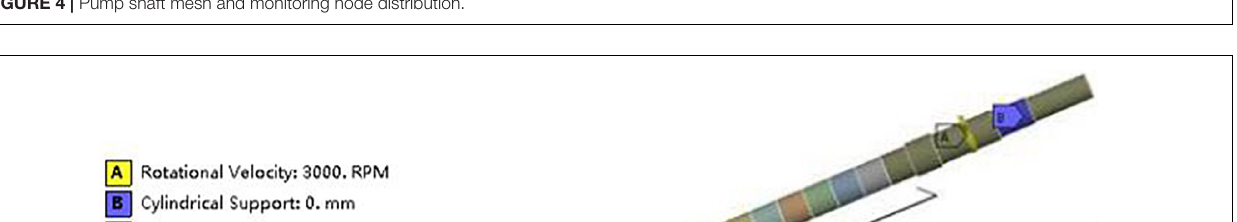
FIGURE 4 | Pump shaft mesh and monitoring node distribution.